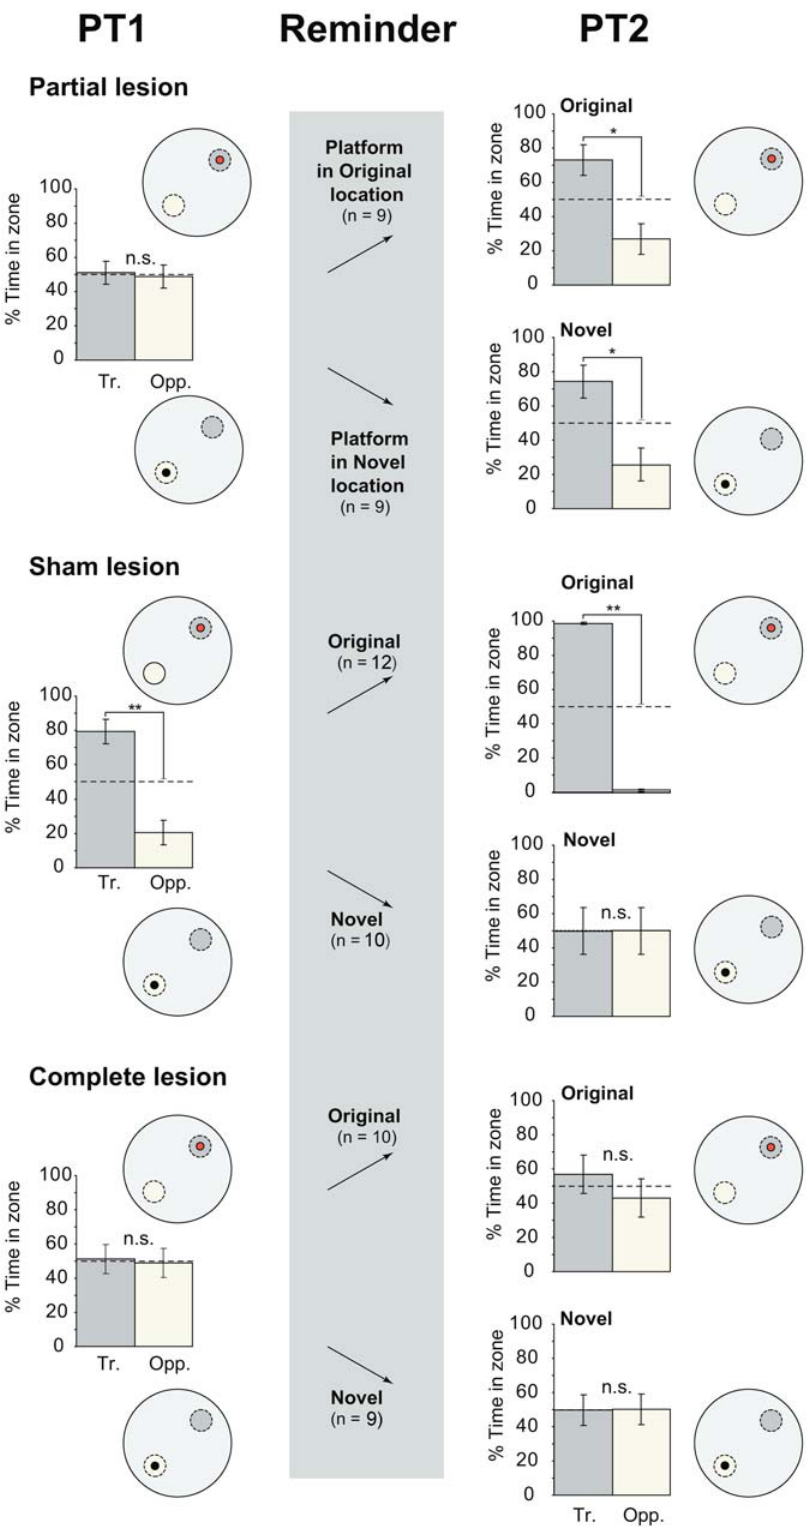
Figure 5. Retention Testing: Zone Analysis Percentage time in PT1 (left) and PT2 (right) spent within a zone, 20 cm in radius, centred on either the original training location (broken circle; grey) or an equivalent location in the opposite quadrant (broken circle; yellow), ex- pressed as a percentage of the total time spent in both of the zones. The reminder treatment is again shown as the grey central lane and as the location where the hidden platform became available at the end of PT1 within these zones (original = red; novel = black). Con- sistent with Figure 4, rats with partial hippocampal lesions were amnesic in PT1 but could be reminded of the correct location, even by exposure to the platform in a novel location. * p